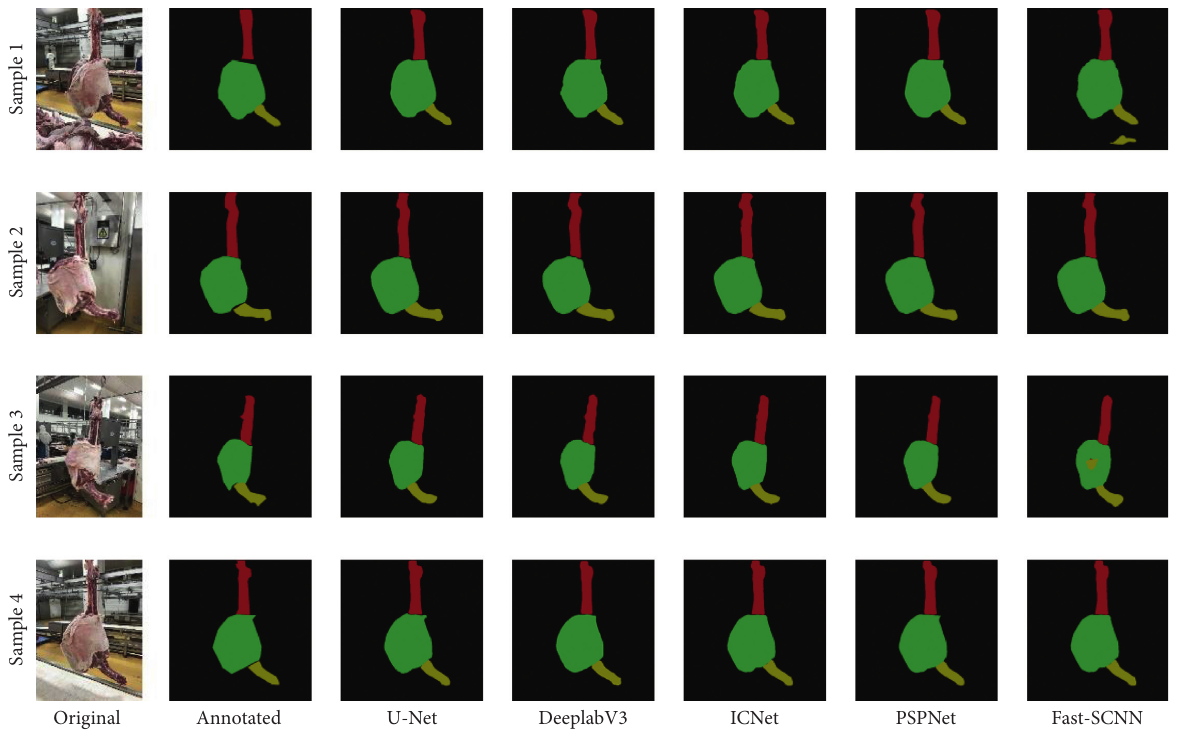
Figure 11: Examples of segmentation by different methods on four samples.